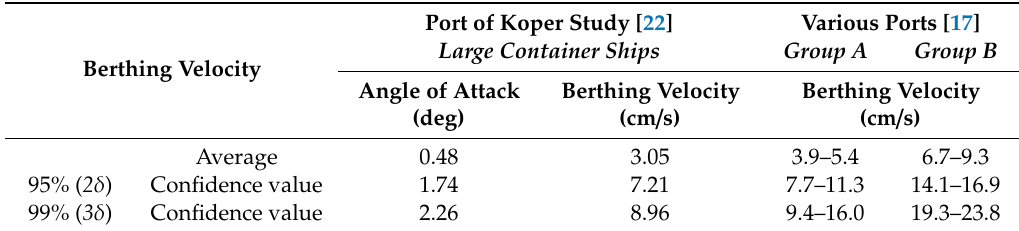
Table 4. Berthing